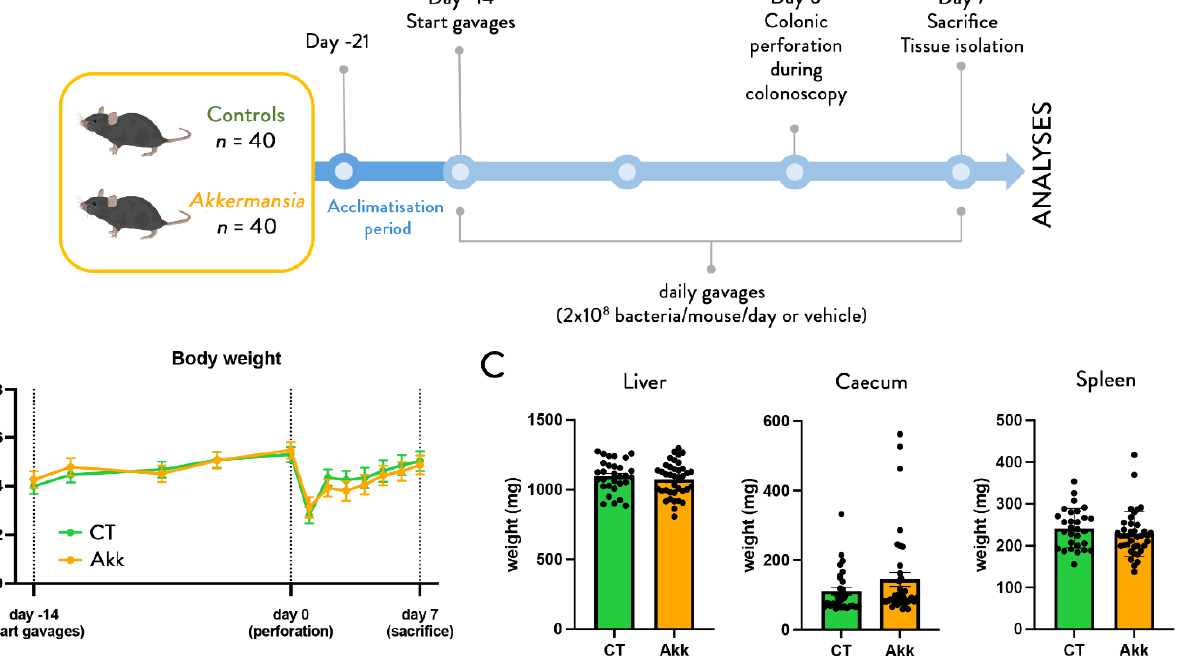
Figure 1. A. muciniphila does not affect body weight and organ weights. ( A ) Experimental design. ( B ) Body weight evolution before and after colonic perforation in control mice and mice treated with A. muciniphila . ( C ) Weight of liver, caecum, and spleen ( n = 40 per group) corresponding to the results of two independent experiments. Data are represented as mean +/ − SEM and black dots (dotplots) represent individual values for each animal, statistical difference assessed using t -test, p -value > 0.05.